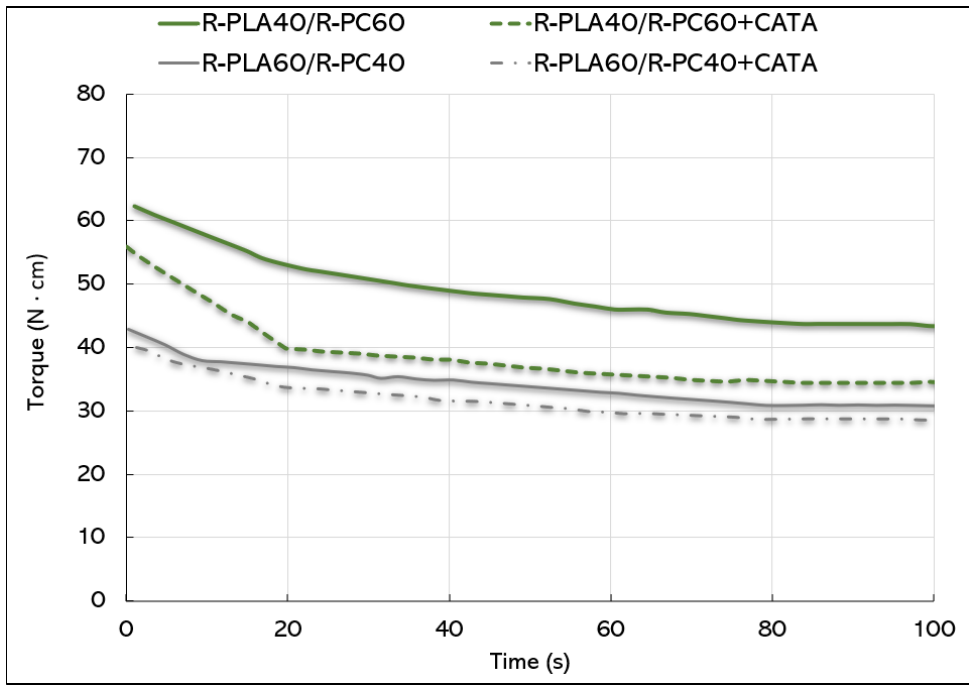
Figure 5. Torque trend for the R-PLA/R-PC blends .